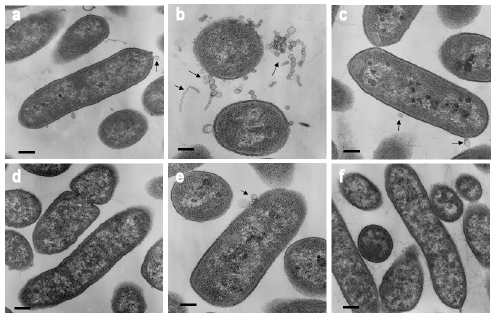
Fig 3. Transmission electron micrograph of BF2766 mutant B . fragilis cells. B . fragilis cells were fixed with 2% glutaraldehyde/PBS and analyzed by TEM to observe OMVs. OMVs (arrows) were observed in wild- type B . fragilis (panel a). The ON/ON locked mutant (panel b) produced a large number of OMVs that formed clusters or chains. Plasmid complementation of the ON/ON mutant with intact BF2766 decreased OMV production to wild-type levels (panel d). The level of OMV production was similar among the OFF/ON (panel c), OFF/OFF (panel e), and ON/OFF (panel f) mutants. Bar: 0.1 μ